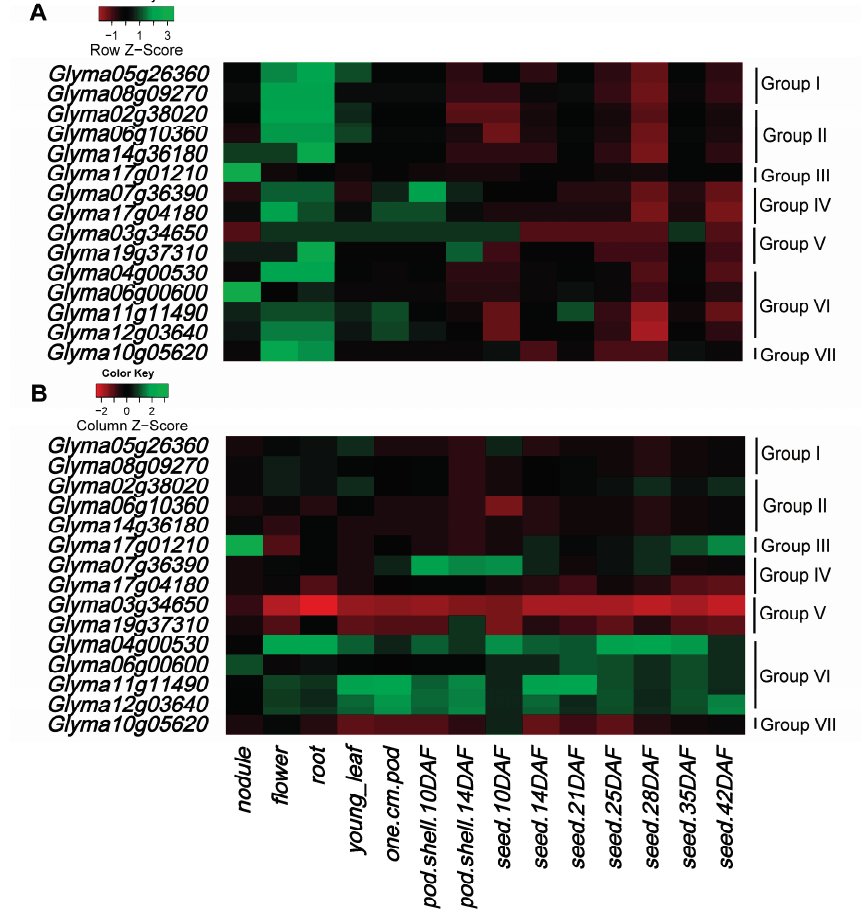
Figure 7. Heatmap of expression profiles of soybean HECT genes in 14 tissues. Normalized transcriptional levels were obtained from Severin et al. [33]. The RNA-seq relative expression data of 14 tissues was used to reconstruct the expression patterns of soybean genes. Color in the heatmaps represents Z -score of RPKM values of soybean HECT genes calculated per row (gene) ( A ) and per column (tissue) ( B ), respectively. Z -scores calculated per row ( A ) were used to show the changes of expression of a gene across different tissues, and Z -scores calculated per column ( B ) were used to rank genes for each sample. The sources of the samples are as follows: young leaf, flower, one cm pod, pod shell 10DAF (day after flowering), pod shell 14DAF, seed 10DAF, seed 14DAF, seed 21DAF, seed 25DAF, seed 28DAF, seed 35DAF, seed 42DAF, root, and